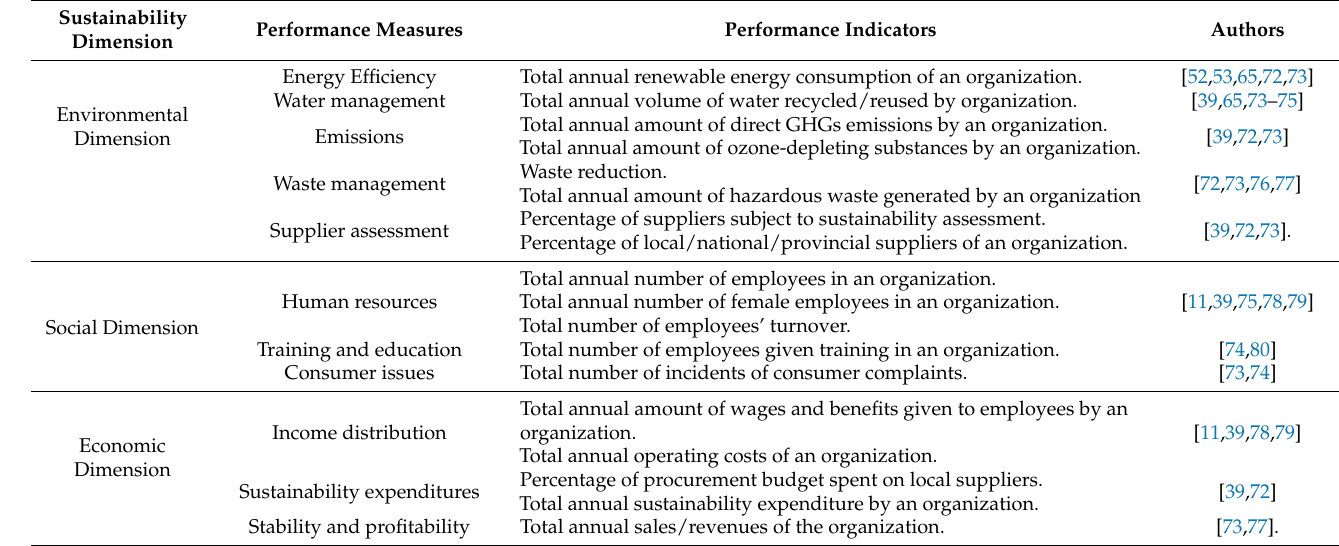
Table 2. Performance Measurement System Proposal for Sustainability Assessment. Sustainability Performance Measures Performance Indicators Authors Dimension Energy Environmental Dimension